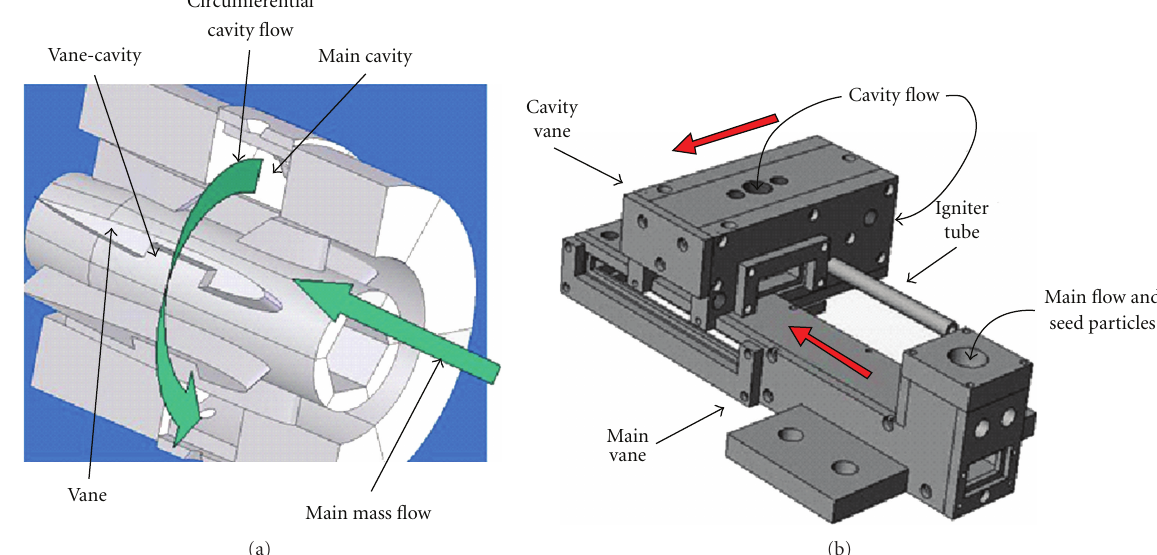
Figure 2: Comparison of (a) a full model UCC concept and (b) the sector model of a straight cavity configuration